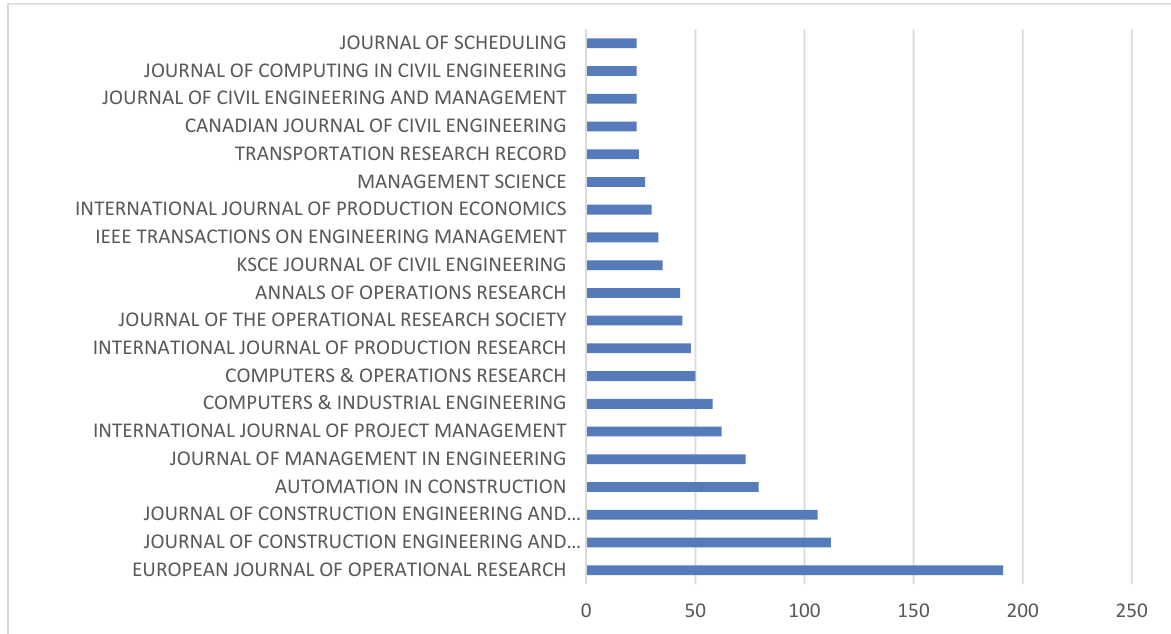
Fig. 3. Most relevent